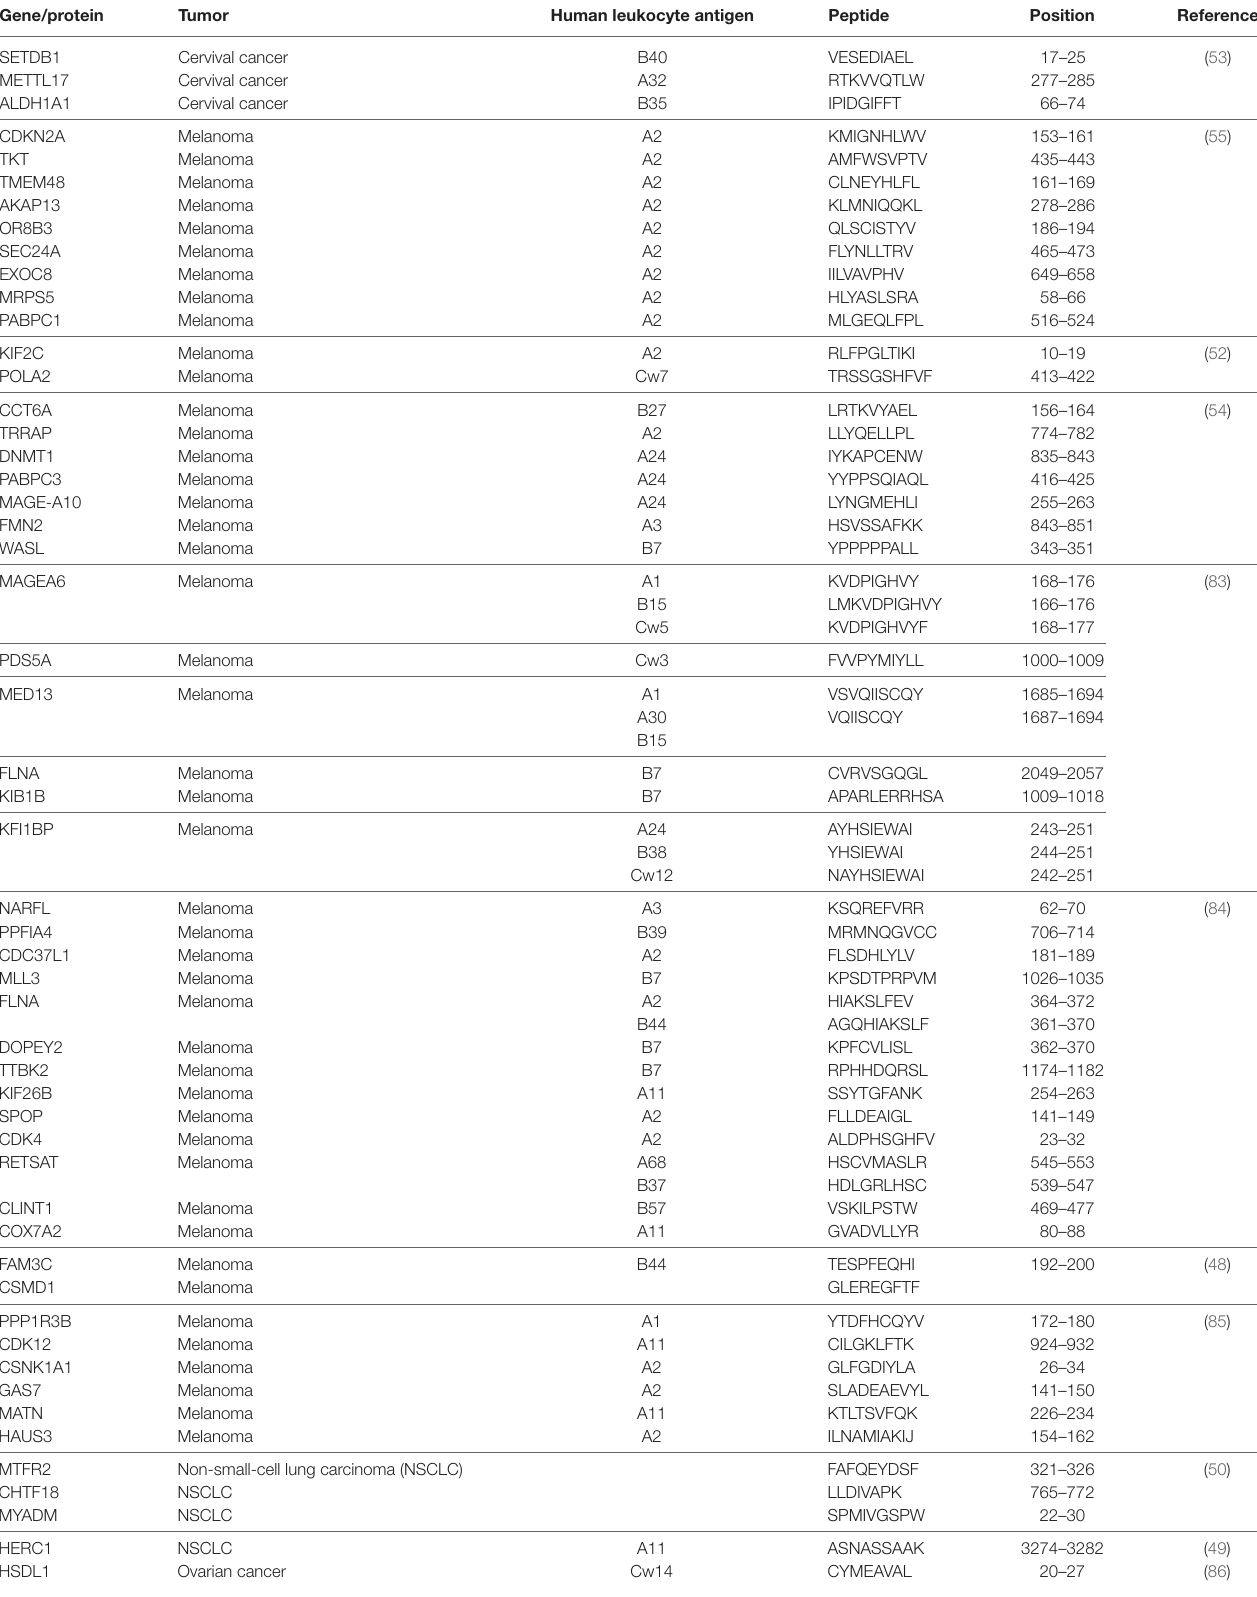
TABLe 3 | Validated mutant antigens identified by WES and recognized by CD8 T cells.